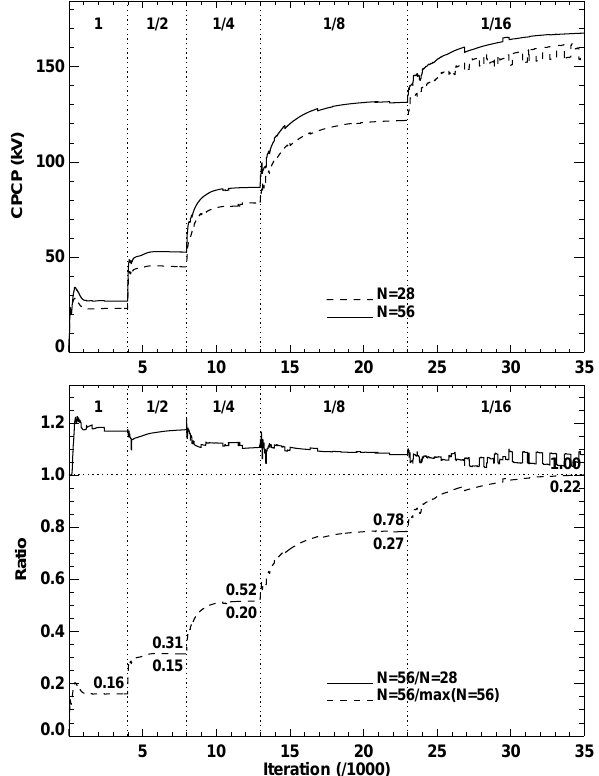
Fig. 9. The top figure shows the ionospheric cross polar cap po- tential as a function of run-time, with an inner boundary density of 28cm − 3 (dashed) and 56cm − 3 (solid). The smallest grid cell size (in R E ) is indicated above the solid line. The bottom figure shows the ratio between the cross polar cap potentials derived from the simulations using 56cm − 3 and 28cm − 3 as inner boundary density conditions as a function of